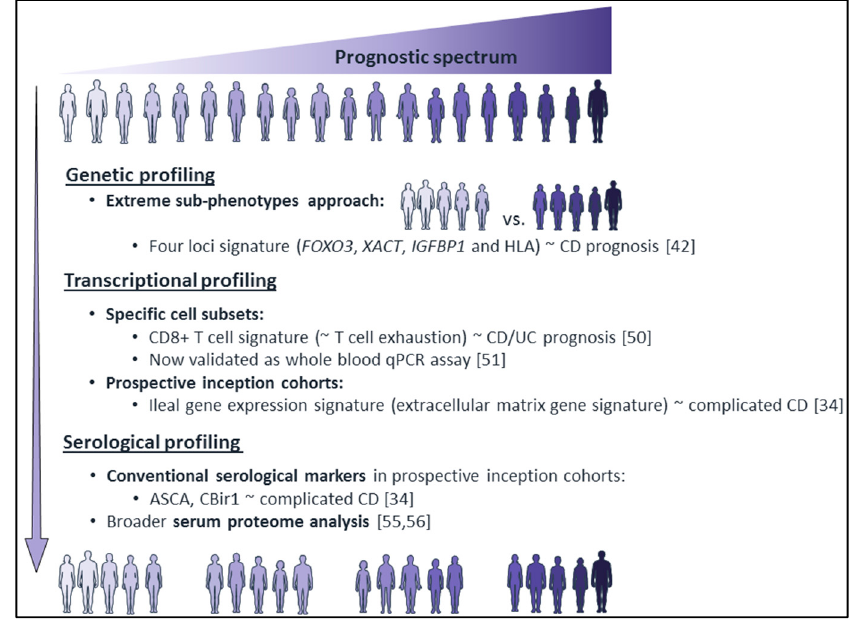
Figure 2. Prediction of IBD disease progression based on molecular profiling. Molecular profiling of disease prognosis using genetics, transcriptomics, and serology has been rapidly evolving. The most promising studies in the IBD filed and their general study designs are shown with references. CD: Crohn’s disease, UC: ulcerative colitis, ASCA: anti- Saccharomyces cerevisiae antibodies, Cbir1: anti-flagellin antibodies.